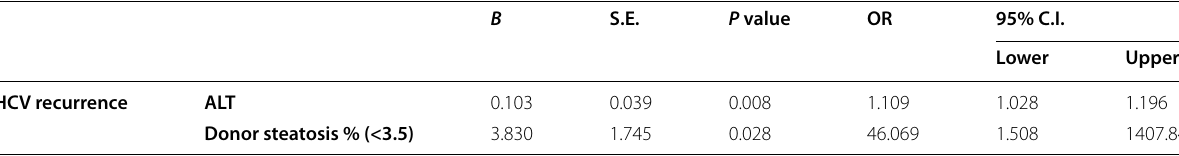
S.E standard error OR odds ratio CI confidence interval